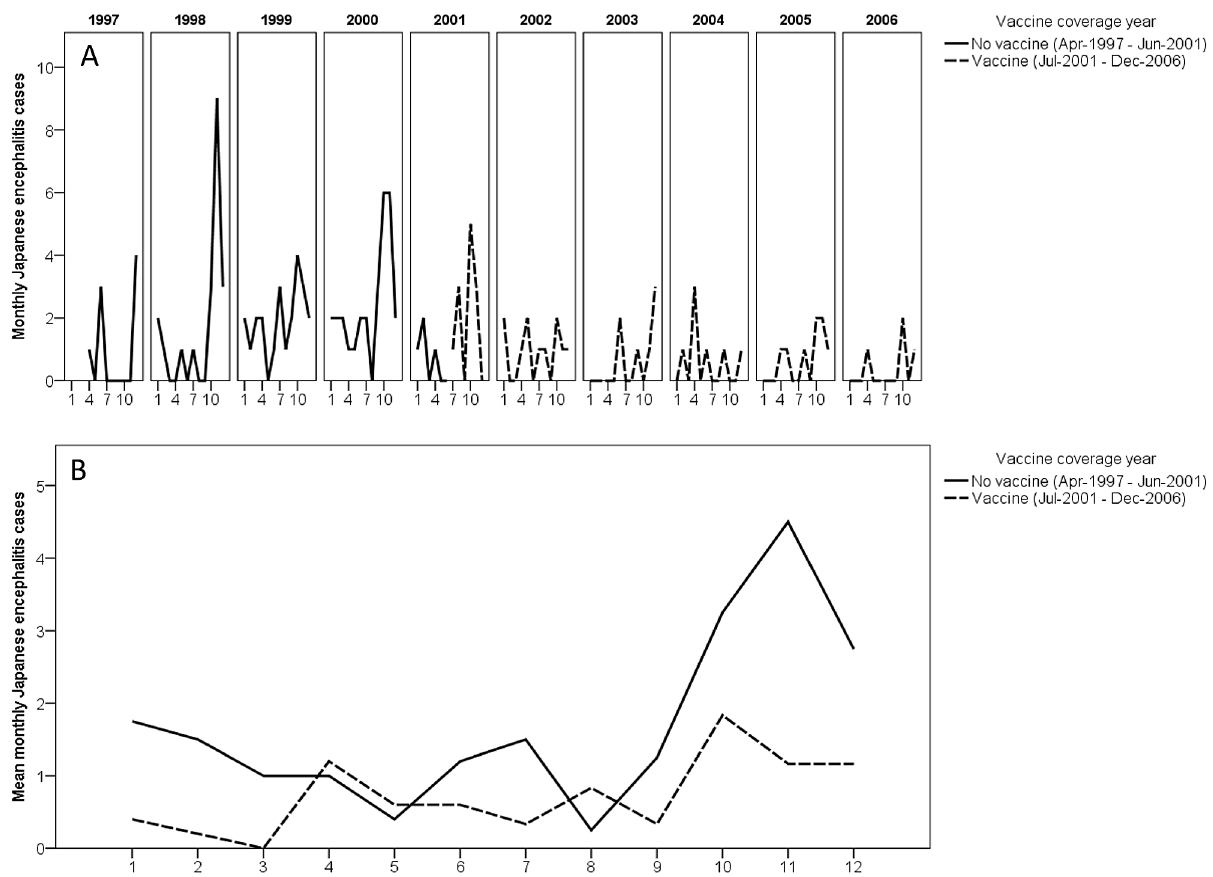
Figure 1. Time series (A) and seasonality (B) of confirmed Japanese Encephalitis cases from Sarawak, Malaysia from April 1997 to December 2006.